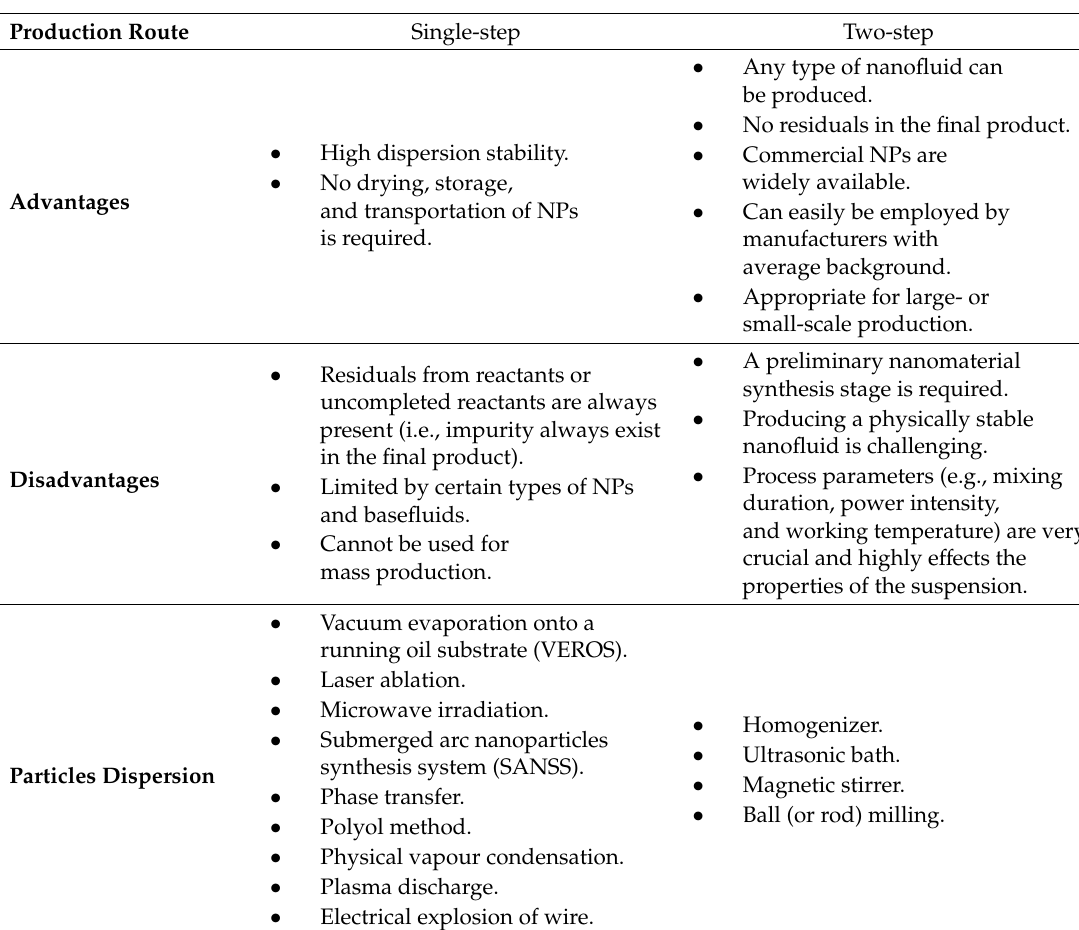
Table 1. Nanofluids production methods, advantages, disadvantages, and particles dispersion